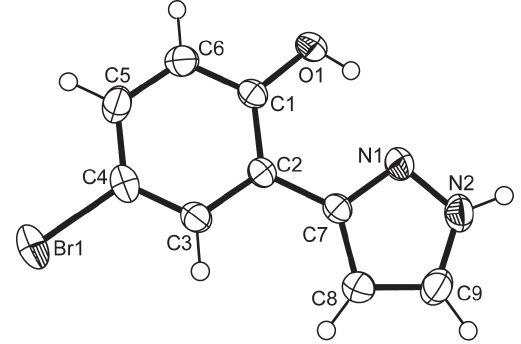
Table 1: Data collection and handling.